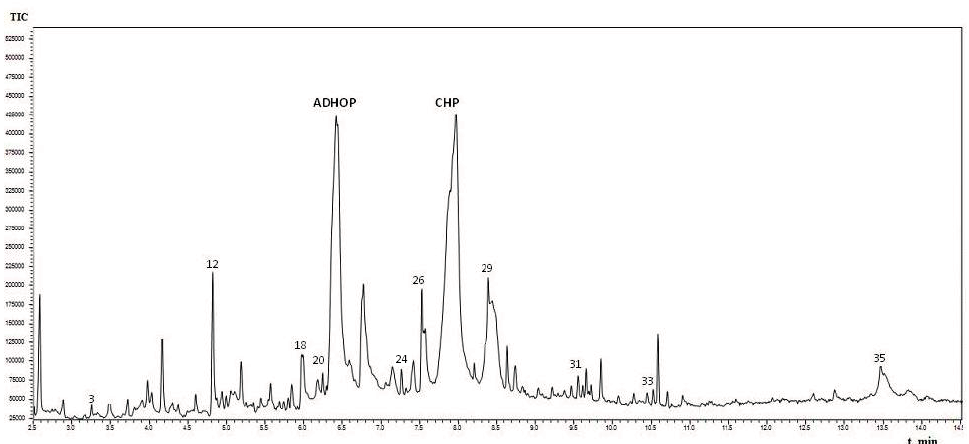
Figure 2. GC-MS chromatogram of Quercus cortex extract (“B” sample). Where: (ADHOP) 2-amino-9-[3,4-dihydroxy-5-(hydroxymethyl)oxolan-2-yl]-3 H -purin-6-one,